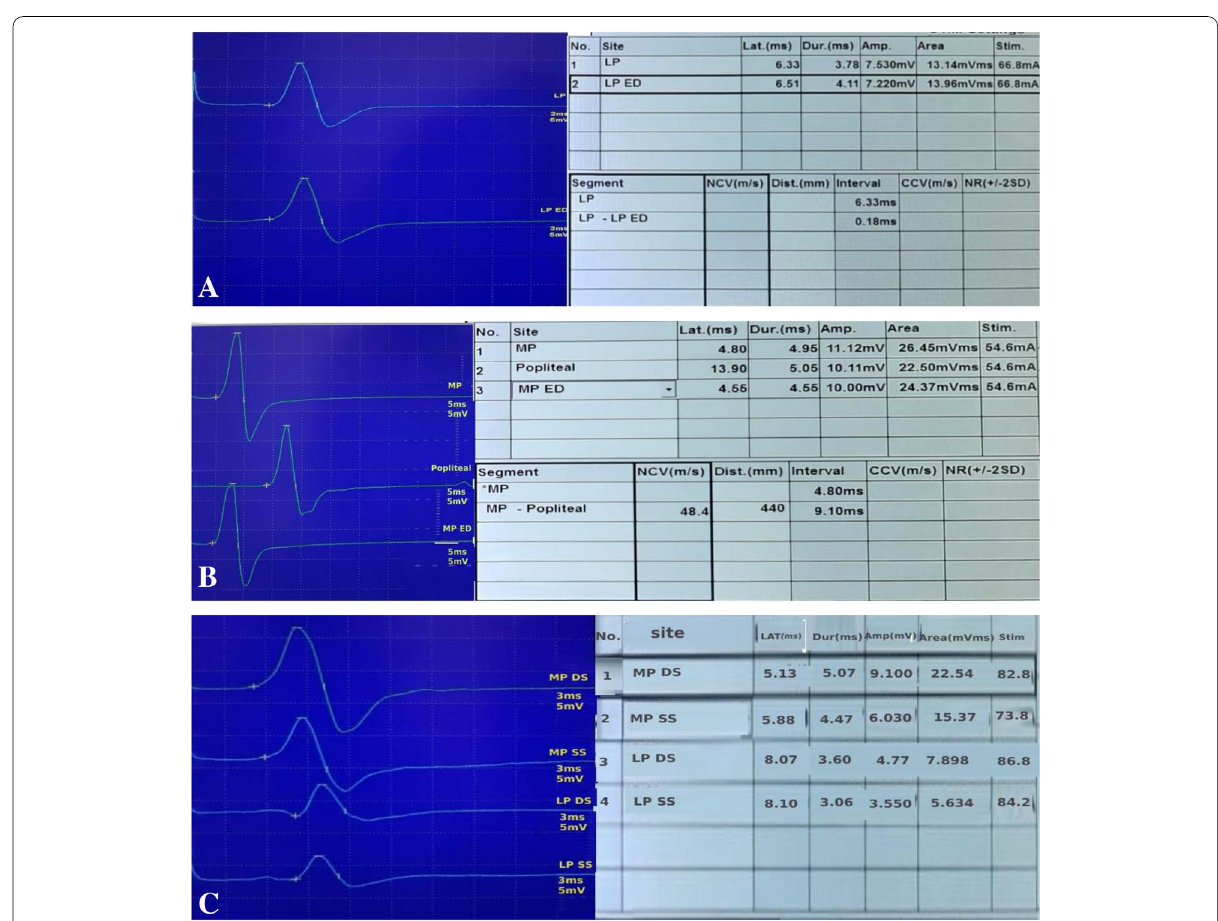
amplitude by the novel tests (ED, SS, and DS) more marked with the last 2 tests ( A , C )